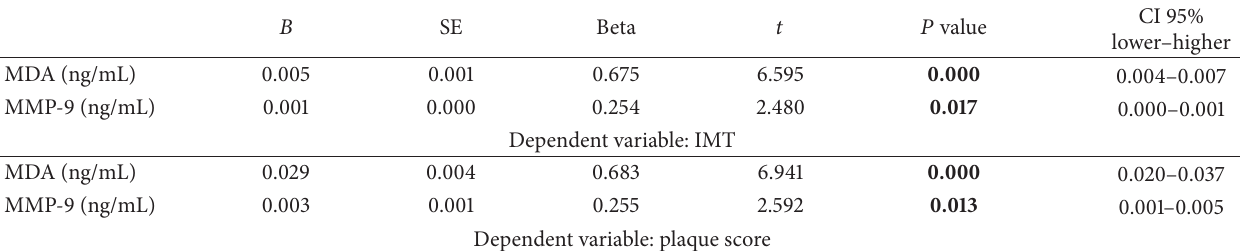
Table 3: Multiple regression model of study biomarkers and their relation with indicators of carotid atherosclerosis in observed CKD and PD